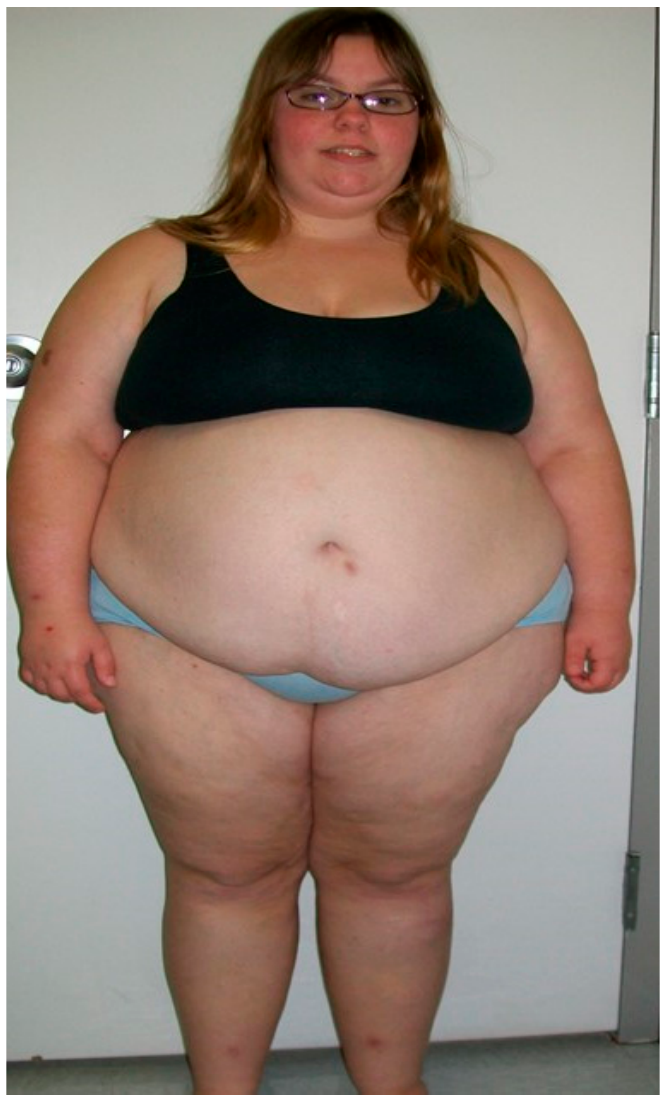
Figure 1. Frontal view of a 16-year-old female with Prader–Willi syndrome due to maternal disomy 15. (Modified from Mahmoud et al. [14]).